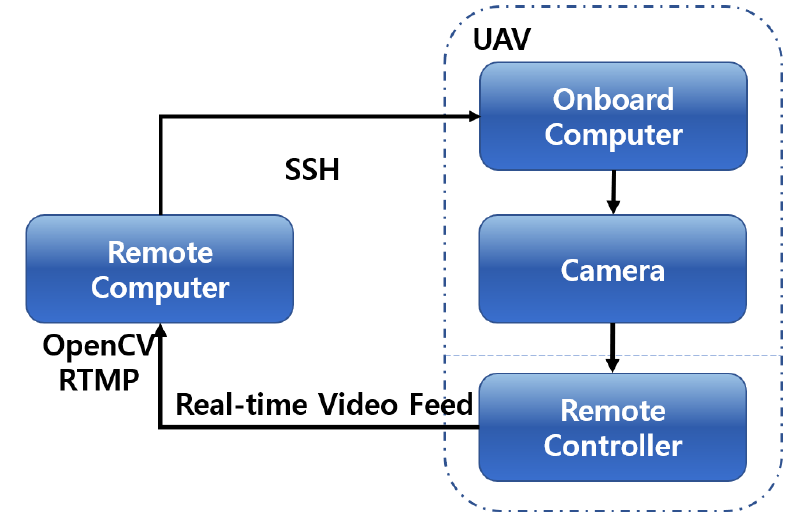
Figure 13. Software setup prepared to get real-time video